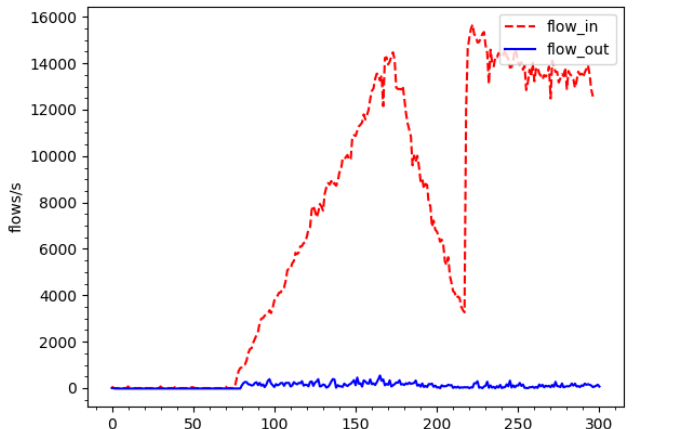
Figure 10. TCP flows entering and leaving the controller.